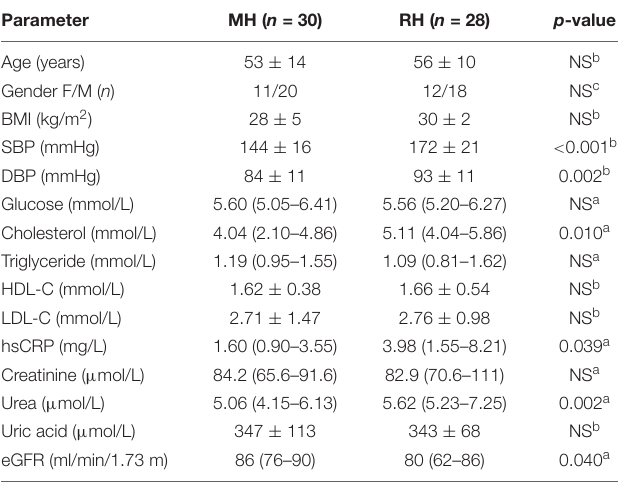
TABLE 2 | Comparison of biochemical parameters between MH and RH group.